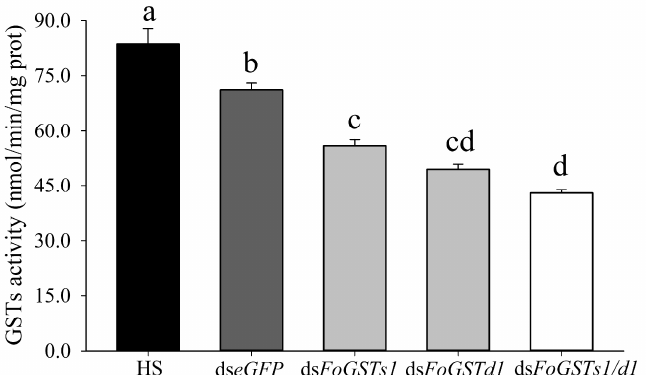
Figure 8. Effects of downregulation of FoGSTs1 and FoGSTd1 expression levels by RNA interference on glutathione S-transferase activity in second-instar larvae of Frankliniella occidentalis . Values are the mean ± SE. Different lowercase letters indicate significant silencing among all treatments ( p < 0.05; one-way ANOVA, followed by Tukey’s test).